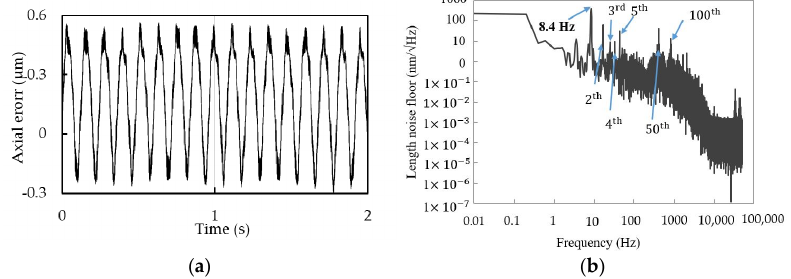
Figure 3. Axial error measurement result using the frequency-modulated interferometer. ( a ) axial error; ( b ) noise level. Crystals 2021 , 11 , x FOR PEER REVIEW